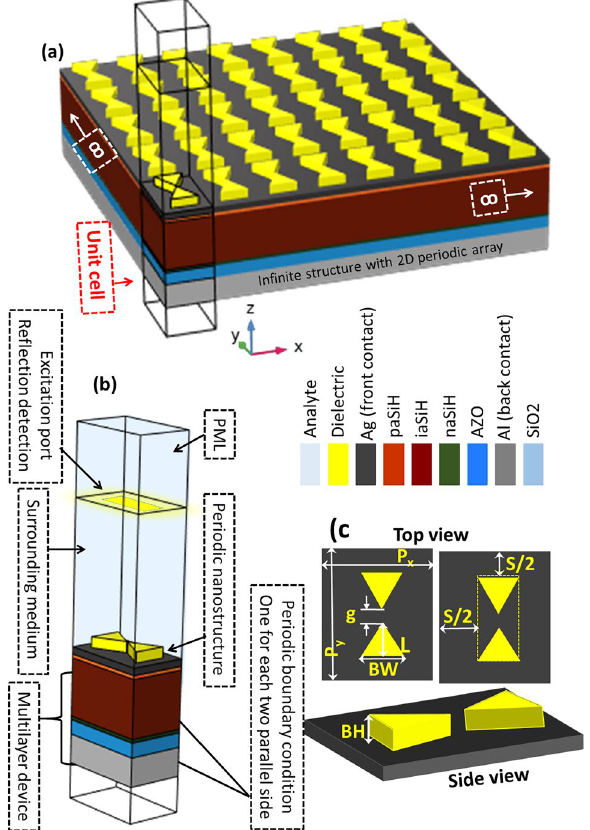
Figure 2. ( a ) 3D representation of the proposed device with an infinite array of bow-tie resonant structures. The unit cell is highlighted on the left bottom corner. ( b ) Detailed arrangement of the unit cell including the excitation port, the boundary condition represented as periodic conditions at the lateral surfaces and as a perfect matche layer (PML) on top, the multilayer structure of the device, the top analyte medium, and the substrate. The color index on the middle defines all the materials included in the device. ( c ) Top and side view of the proposed structure with all the geometrical parameters.